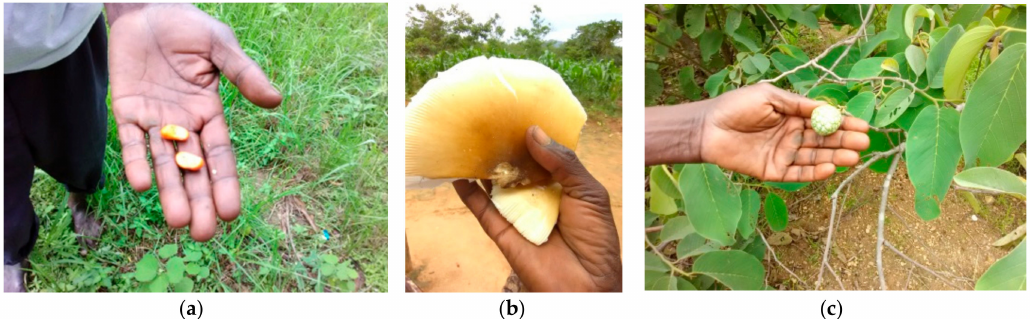
Figure 5. Selected forest goods in Chikutu: ( a ) Ndilolo (cashew-like nut); ( b ) Chiwowa (mushroom); ( c ) Munyere (wild